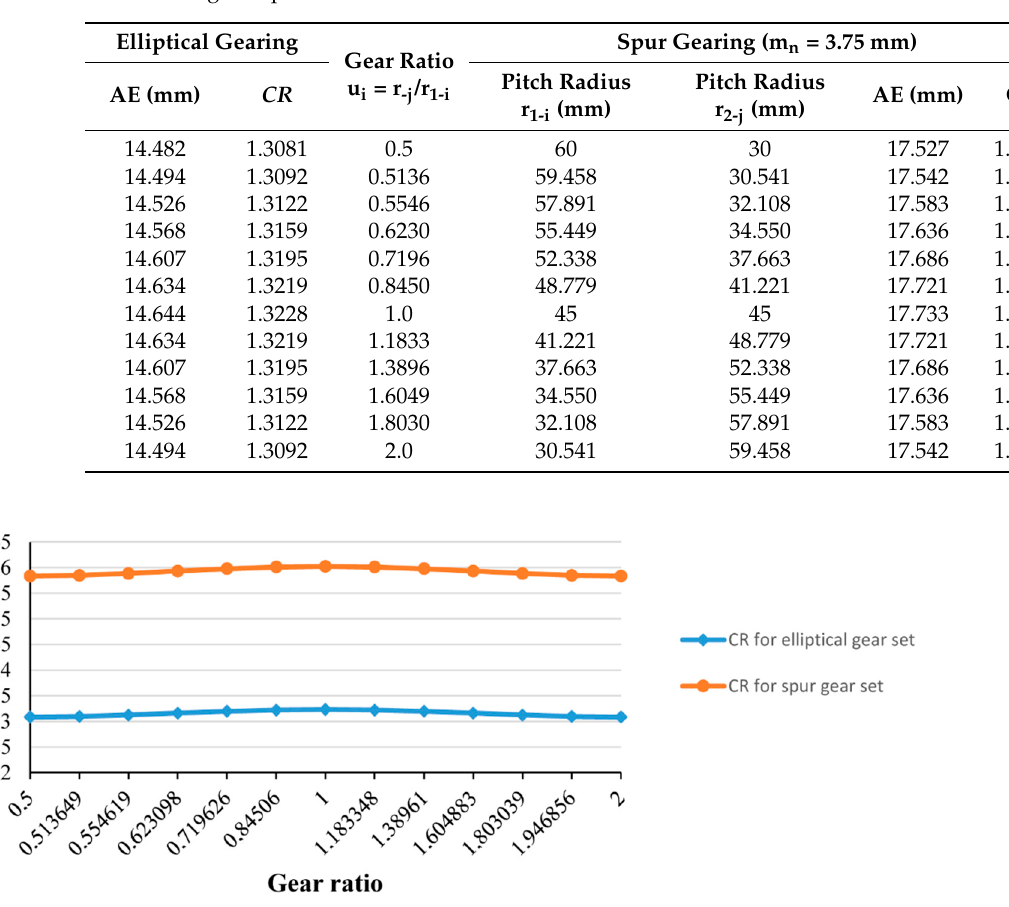
Figure 23. The course of changing gear ratio of the meshing teeth pair, driving wheel tooth number 24 and drive wheel tooth number 12.